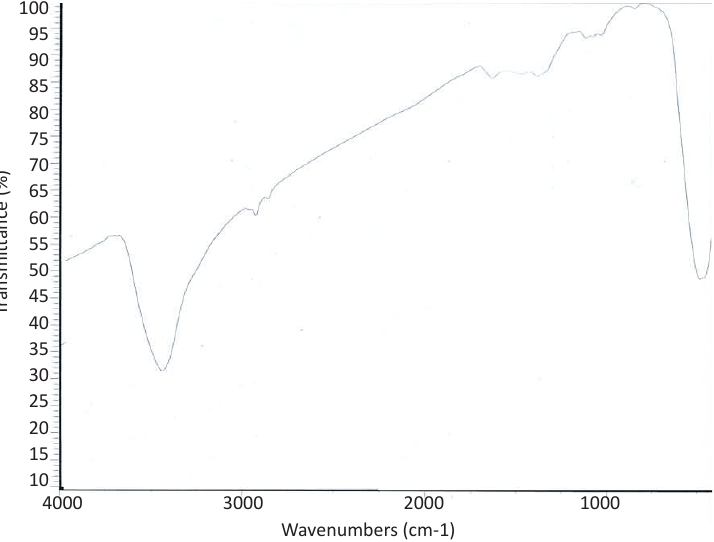
Fig.6. FT-IR spectrum of CuFe